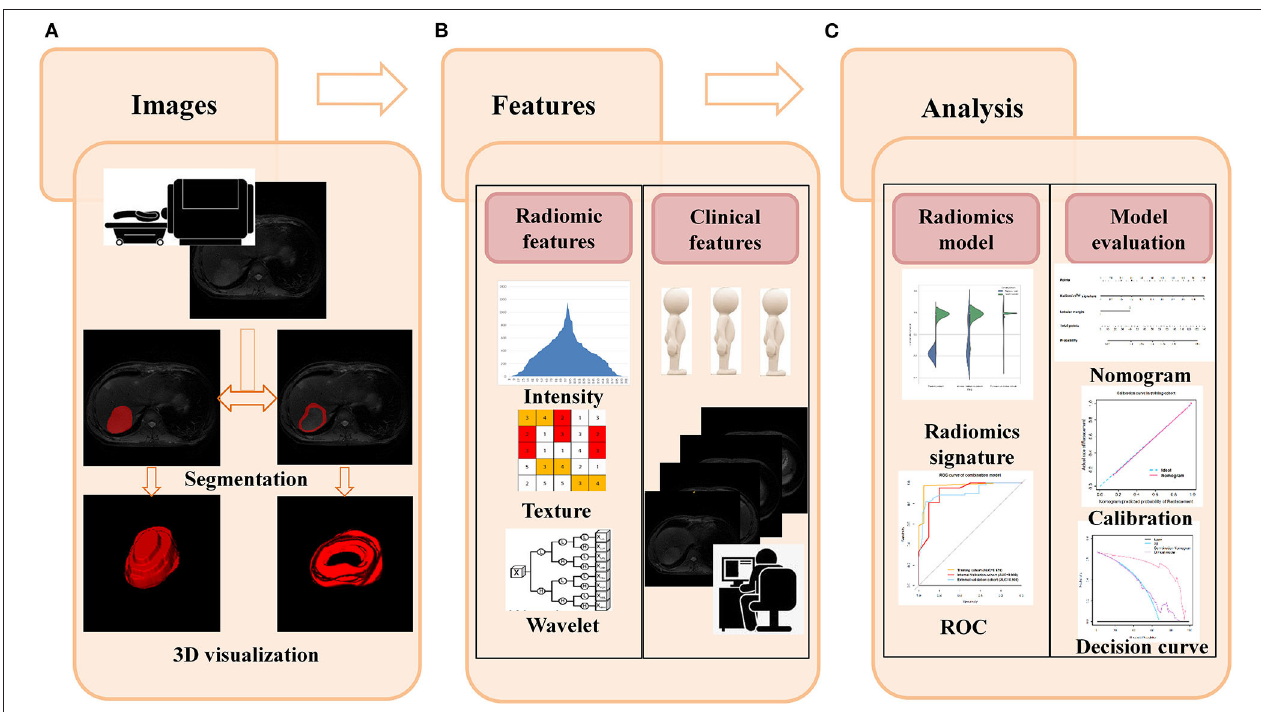
FIGURE 1 | Flowchart for this study. (A) The T2W images were used as an example to illustrate the segmentation process, and slicer-to-slicer delineation obtained two sets of ROI. (B) Multiple radiomic features were extracted from two sets of ROI. Clinical features were obtained from medical records, and qualitative gross imaging features were evaluated by two board-certified radiologists. (C) Intra-/inter-observer coefficients were used to select the stability features, and decision tree were used to construct the radiomics model in each sequence. The best performed sequences and related clinical features were used to form the final classification model. The ROC, calibration curve, and decision curve were used to evaluate the performance of